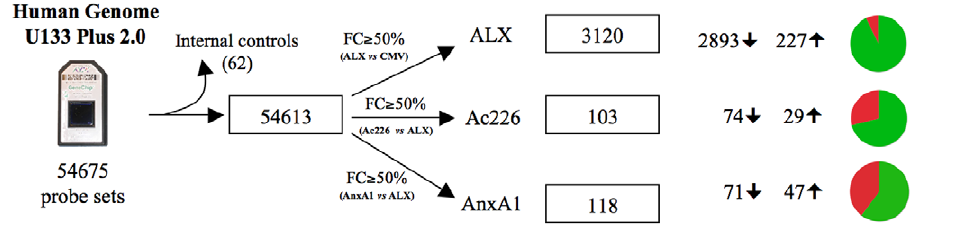
Figure 2. Filtering process and identification of differentially expressed probes in ALX, Ac226 and AnxA1 groups. Internal controls contained in the array were discarded. Then, probes showing a fold change (FC) less than 50% in expression for each group (ALX vs. CMV, Ac226 vs. ALX, AnxA1 vs. ALX) were selected as differentially expressed probes.